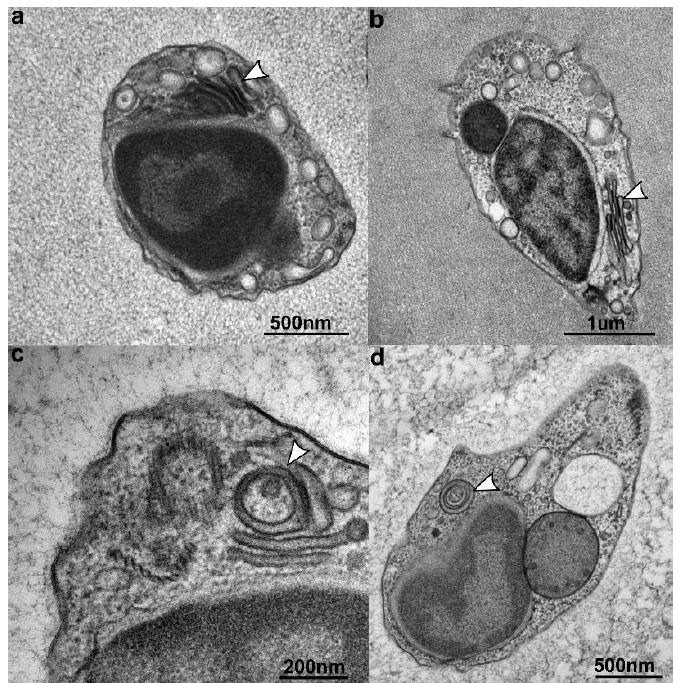
Figure 3. The Golgi apparatus changes shape during the cell cycle (arrow). The Golgi progressively changes from flat-shaped cisternae ( a , b ) stacked on top of each other to a rounded, circular, almost dish-like, shape ( c , d ).